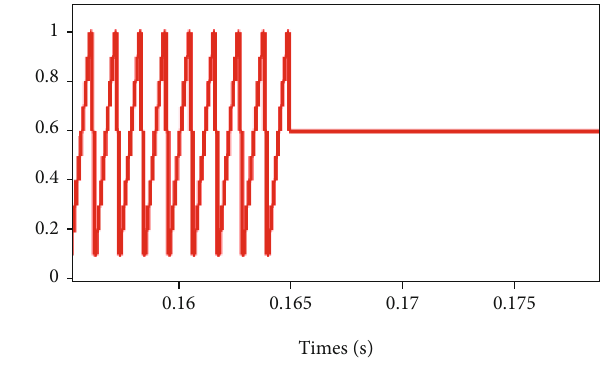
Figure 10: Duty cycle of